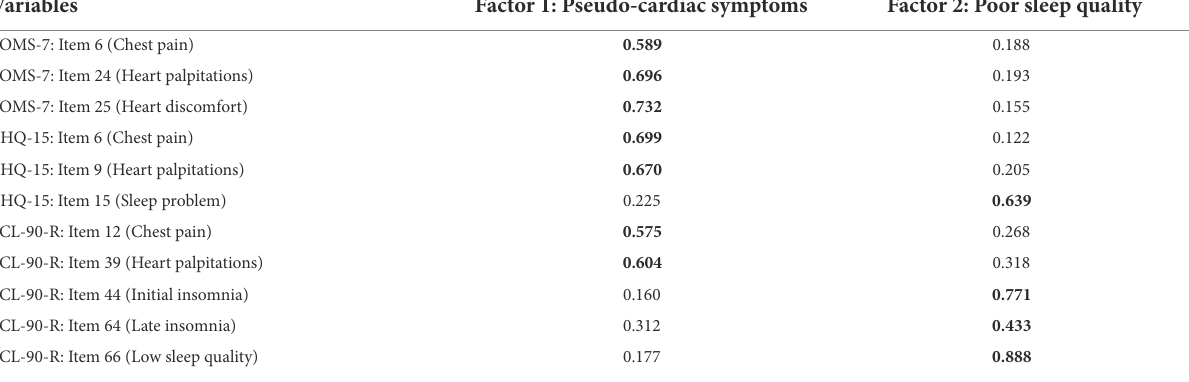
TABLE 1 Rotated factor matrix of several items related to the pseudo-cardiac symptoms and poor sleep quality. Variables